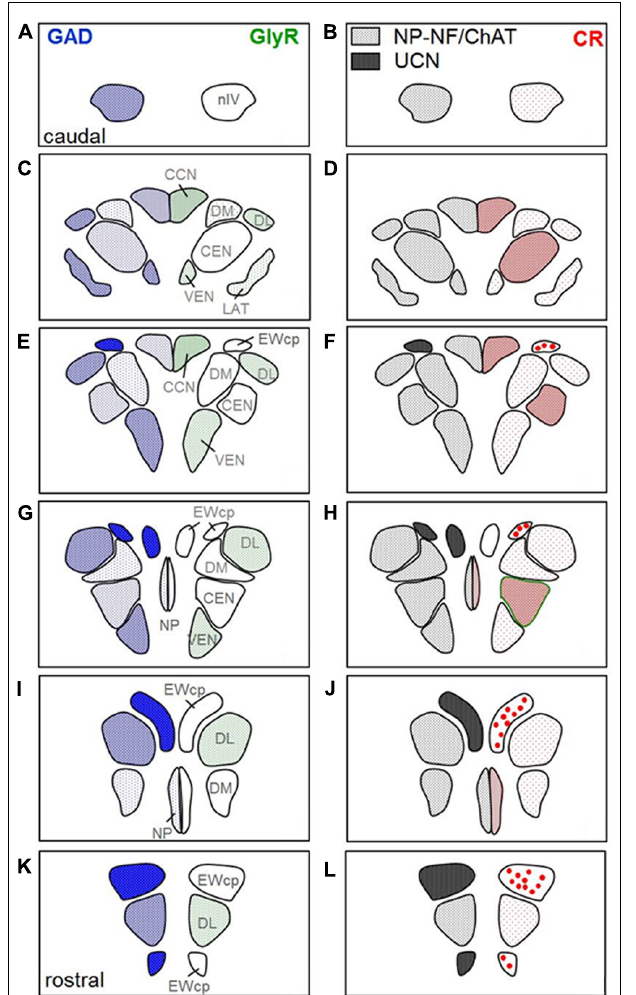
FIGURE 6 |Two parallel series of drawings of transversal sections through the trochlear (nIV) and oculomotor nucleus (nIII) complex arranged from caudal to rostral. Panels (A,B) correspond to the level of Figure 1 , (C,D) to the level of Figure 2 , (G,H) to the level of Figure 3 , and (K,L) to the level of Figure 5 . Panels (E,F and I,J) correspond to additional intermediate levels. On the left, the density of glutamate decarboxylase (GAD) positive puncta and the intensity of immunostaining for the glycine receptor (GlyR) in the different subgroups is indicated by blue hatching on the left and green hatching on the right, respectively.The right column shows the presence of neurons expressing immunoreactivity for urocortin (UCN, black), non-phosphorylated neurofilaments (NP-NF; gray) and calretinin (CR; red filled circles).The density of CR-positive profiles is indicated by different grades of red hatching.